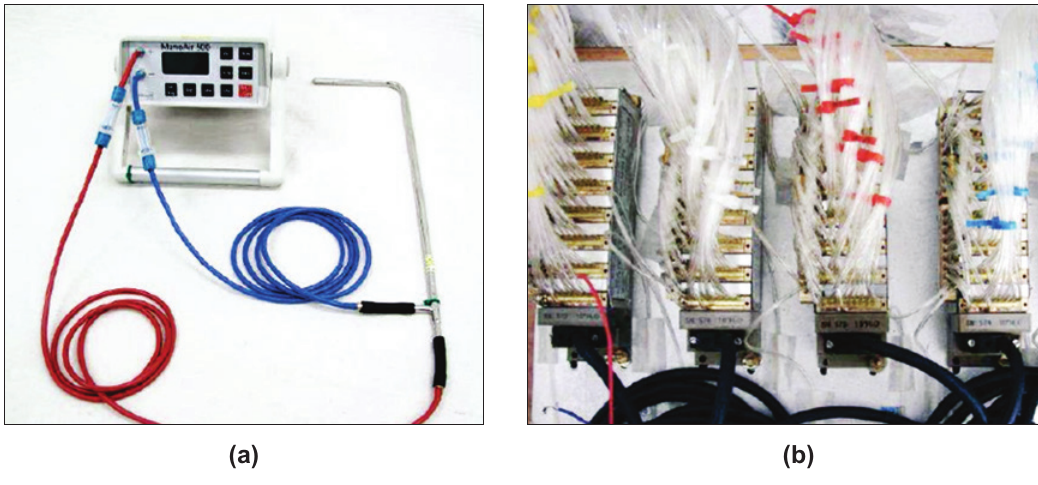
Pressure plug indicators on the CAARC standard building: (a) pressure plug level quotas (unit: m); (b) transversal section with the placement of the plugs